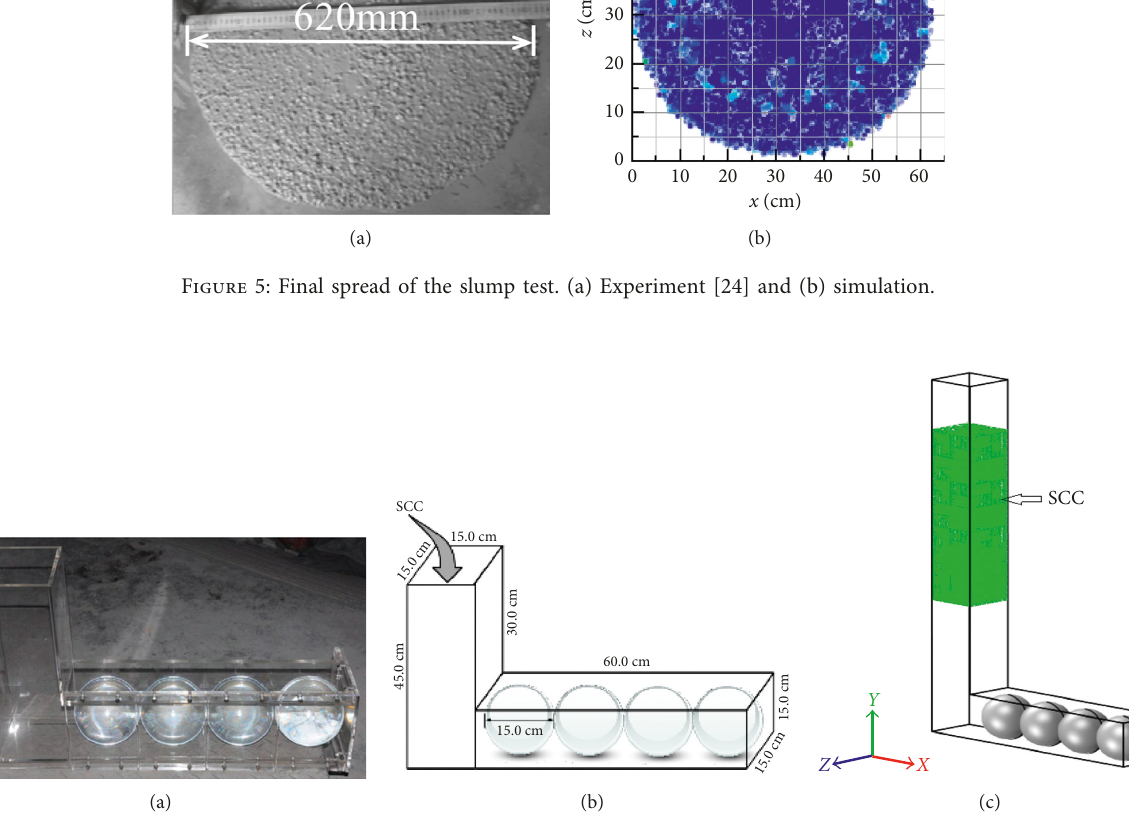
Figure 6: The enhanced L-box test. (a) Experiment setup [24], (b) model size, and (c) LBM